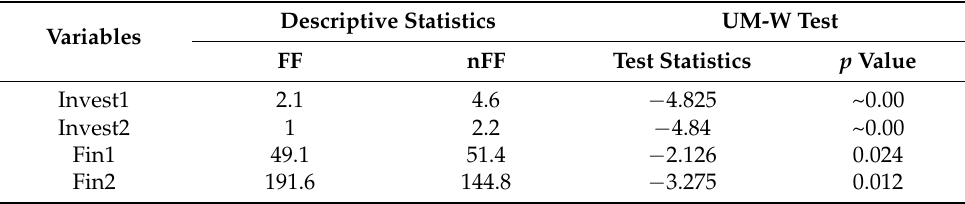
Table 2. Descriptive statistics describing financing strategy in family and non-family firms.